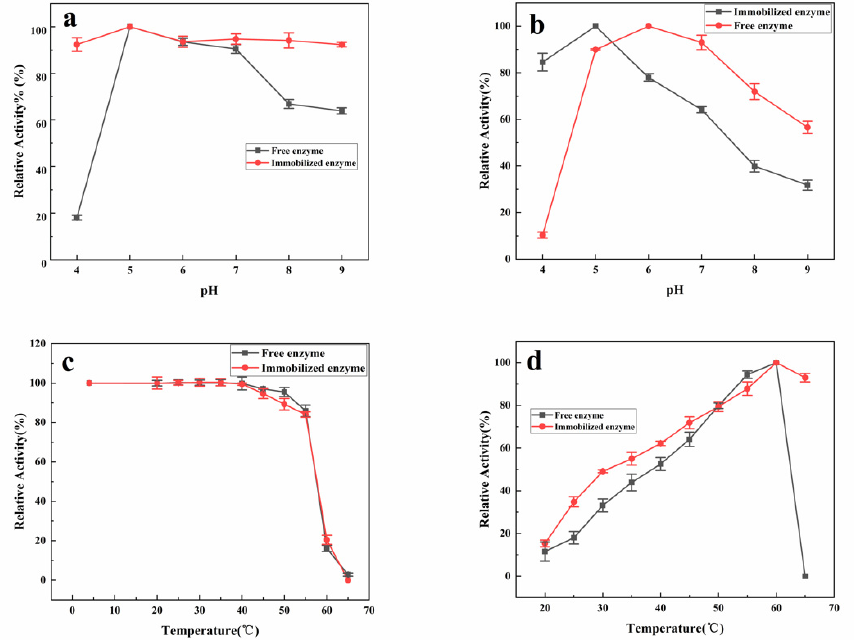
Figure 2. Properties of immobilized dextranase for optimal activity: ( a ) pH stability, ( b ) optimal pH of activity, ( c ) temperature stability, and ( d ) optimal temperature of activity.